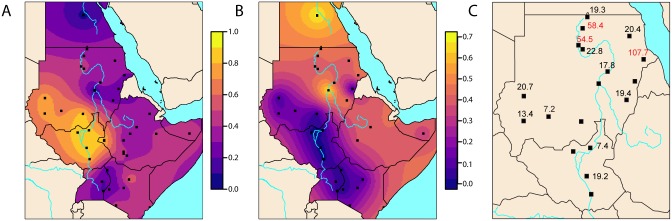
Maps showing the amount of Nilotic and Eurasian admixture and admixture dates in investigated populations.(A) Map shows the distribution of the Nilotic component in Northeast African populations (at K = 7). (B) Estimated non-African (using a European group) admixture using f4-ratios (see Methods). (C) Admixture dates (in generations) of Sudanese populations estimated using patterns of LD decay [34]. Numbers in red indicate multiple admixture events of which the oldest is shown. Populations without admixture dates had no significant results in the analyses for an admixture event between a Sudanese or South Sudanese population and a non-African population. See S7 Table for putative admixture sources.